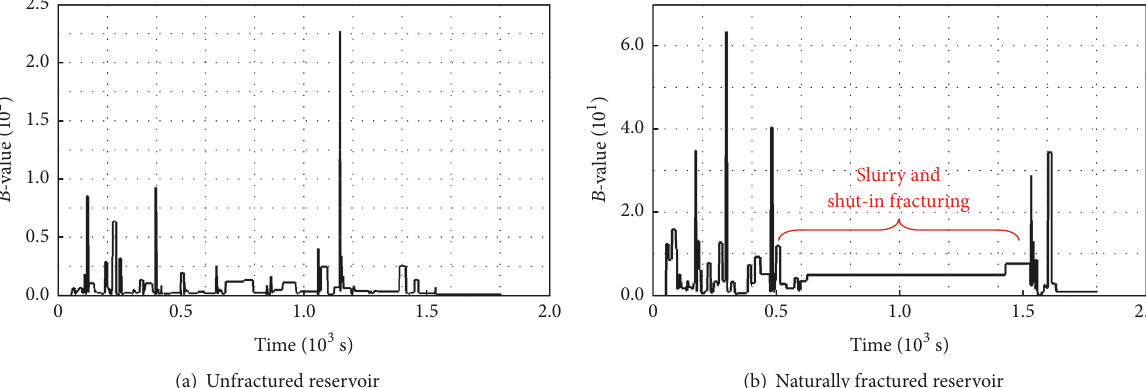
Figure 10: Evolution of 𝐵 -value for damaged events.